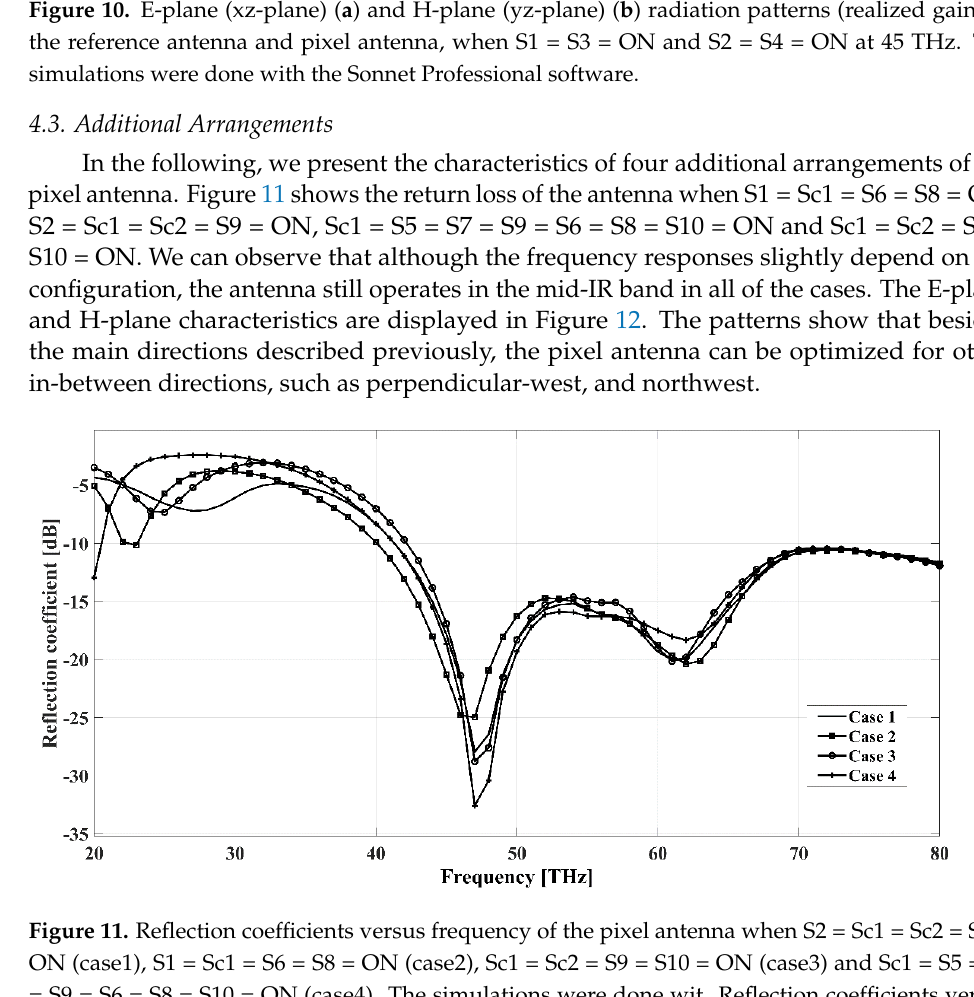
Figure 10. E-plane (xz-plane) ( a ) and H-plane (yz-plane) ( b ) radiation patterns (realized gain) of the reference antenna and pixel antenna, when S1 = S3 = ON and S2 = S4 = ON at 45 THz. The simulations were done with the Sonnet Professional software.